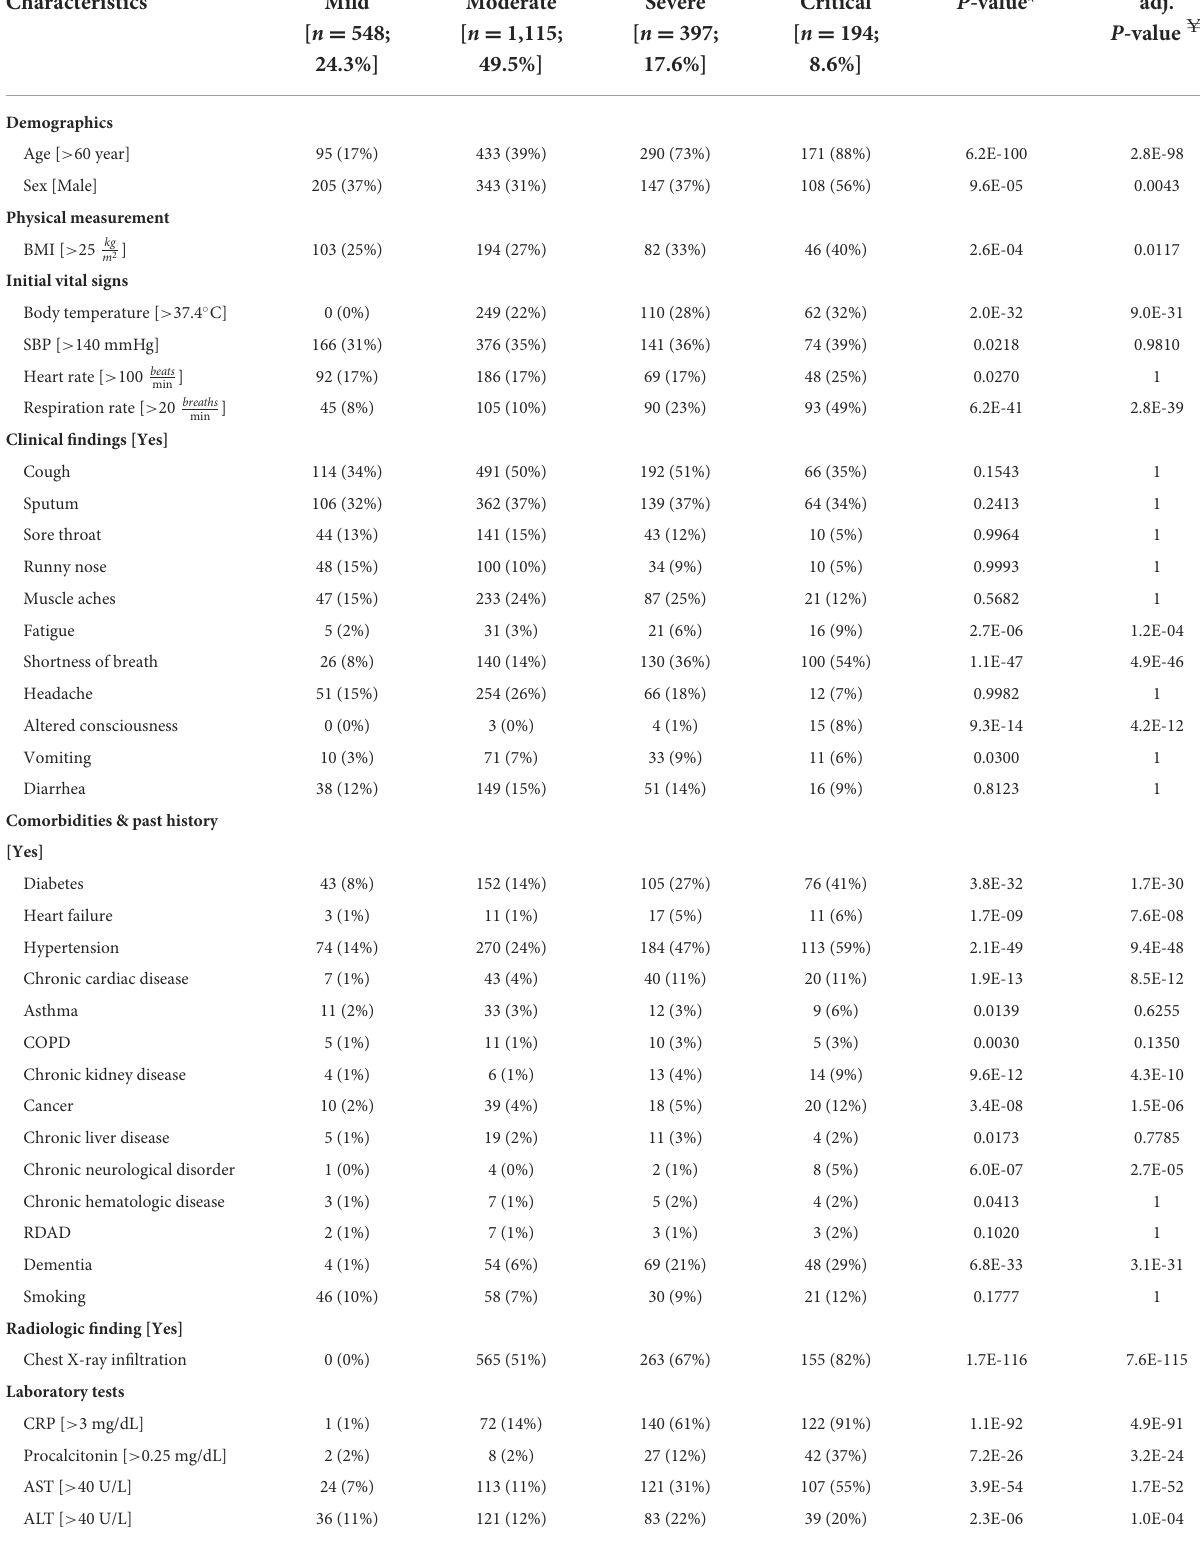
TABLE 2 Patient’s characteristics for each group of the maximum severity.